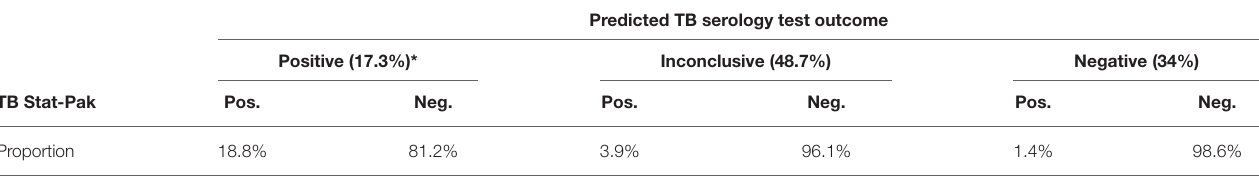
TABLE 1 | Percentages of elephants ( n = 708) per LCA predicted per TB serology test outcome and concordance with the TB Stat-Pak assay outcomes for each of the TB